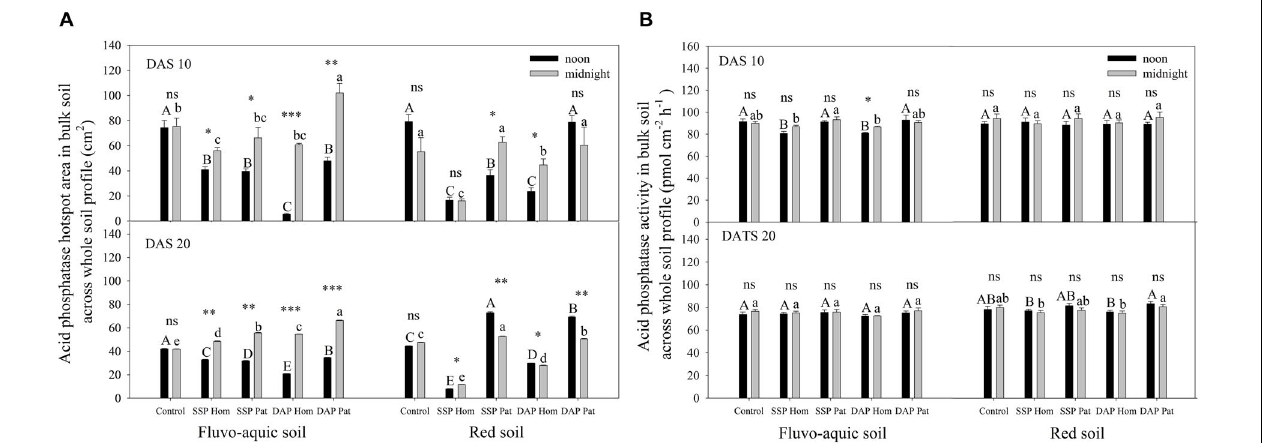
FIGURE 8 | The hotspot area (A) and mean activity (B) of acid phosphatase in bulk soil across whole soil profile on 10 DAS and 20 DAS in fluvo-aquic soil and red soil. Capital letters indicate significant differences between fertilization treatments on noon, lower-case letters indicate significant differences between fertilization treatments at midnight, and asterisks indicate significant differences between noon and midnight in the same rhizobox (significance level: ∗ P < 0.05; ∗∗ P < 0.01; ∗∗∗ P < 0.001; ns, no significant). Each column refers to the mean values of four replicates (+SD).